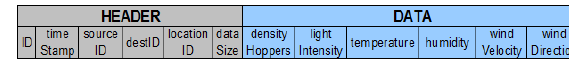
Figure 10. Packet structurein the hopperobservationWSN.